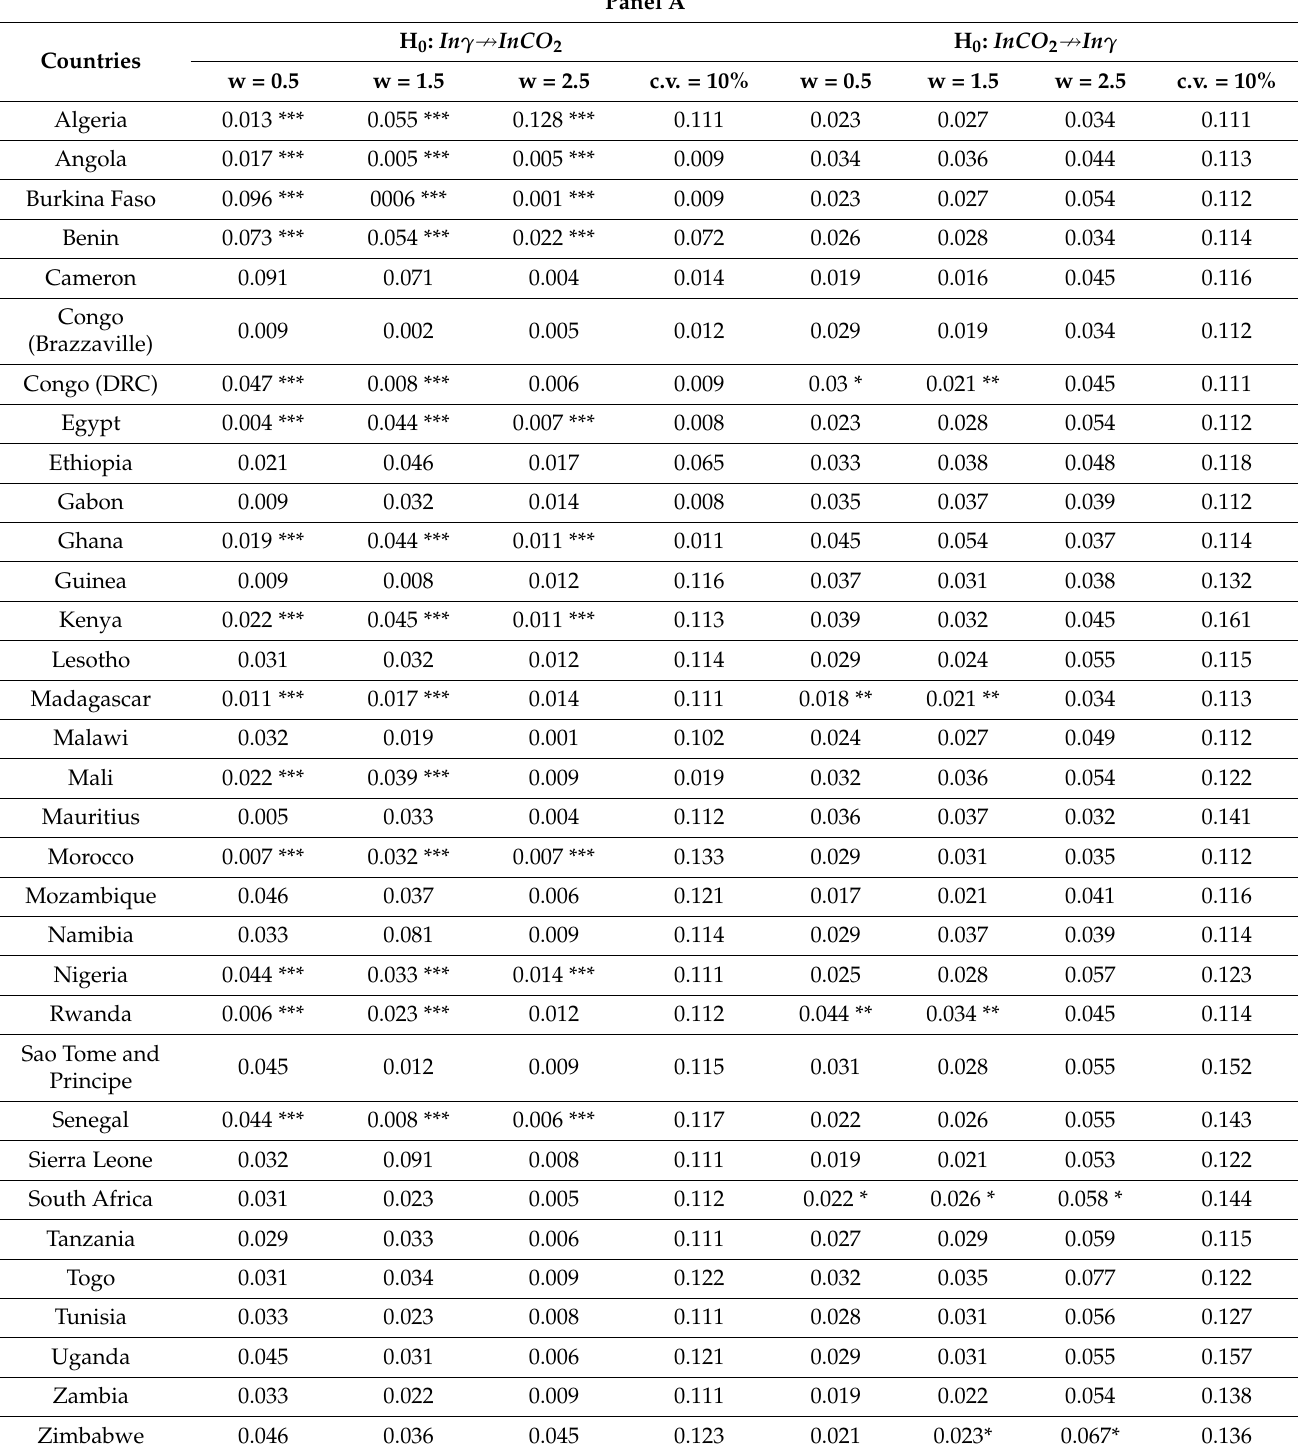
Table 4. Granger causality tests in the frequency domain estimates ( In γ , InCO 2